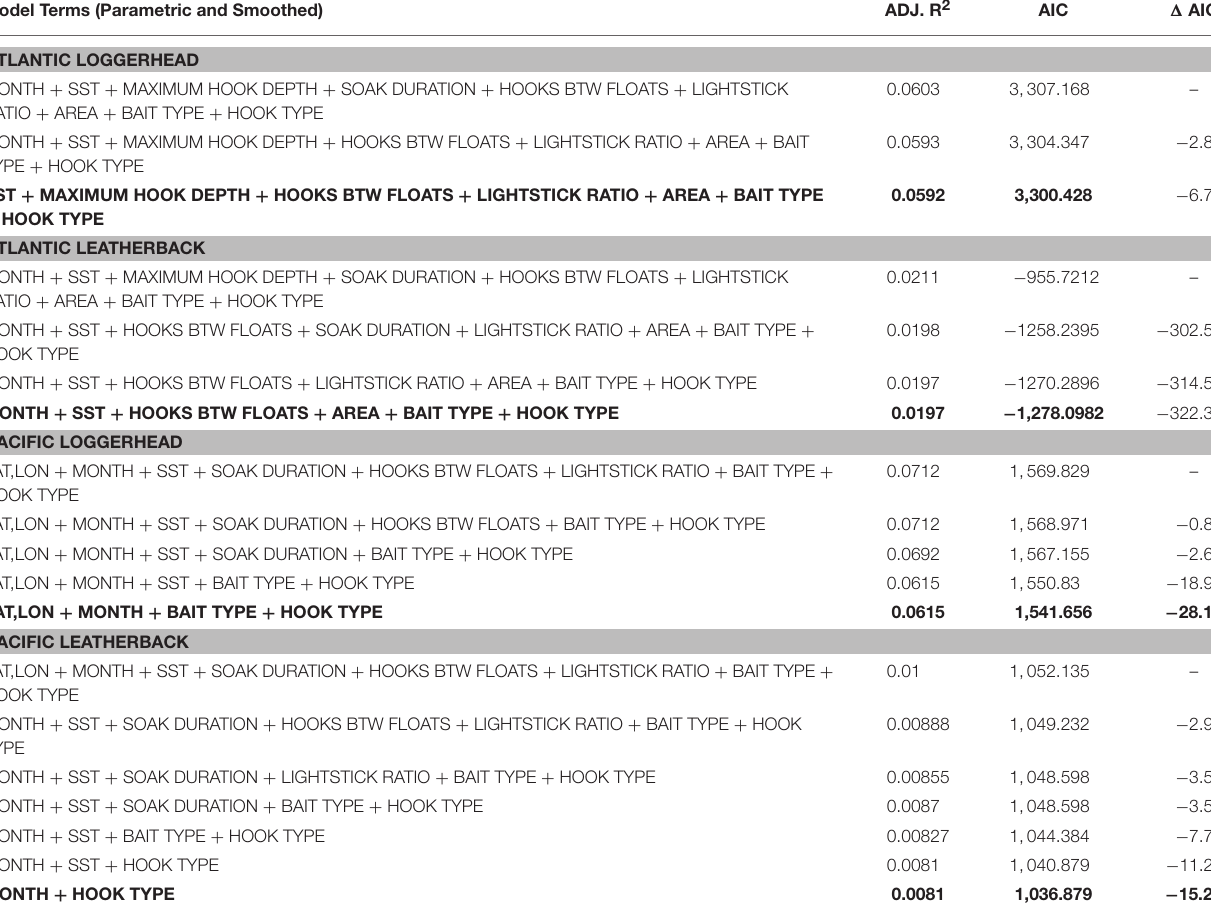
TABLE A1 | GAMM best-fit model